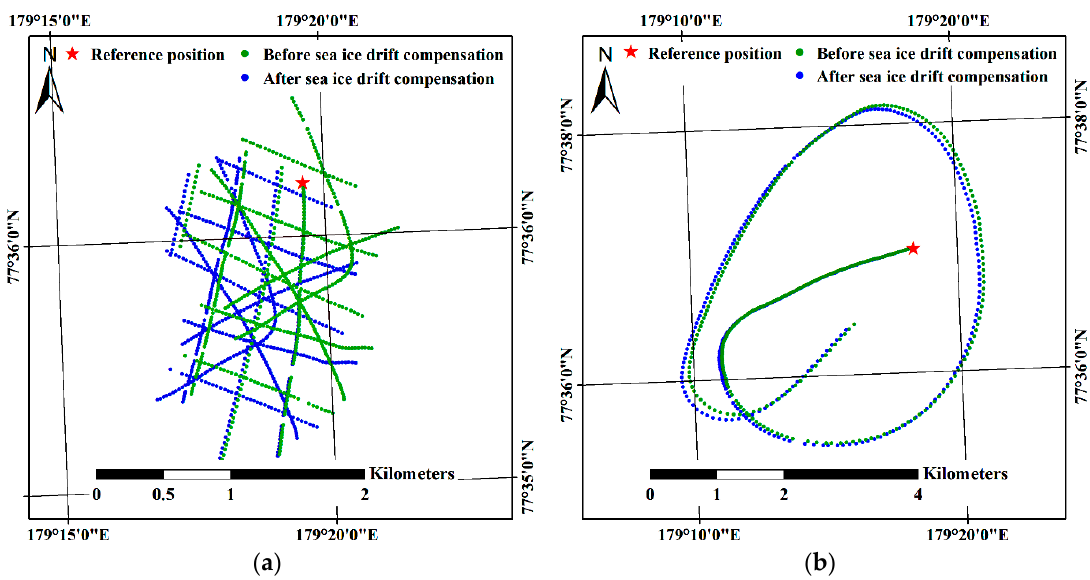
Figure 7. Compensation for the effect of sea ice drift in the helicopter-borne VHR images: ( a ) the imaging locations of Subset I before and after the compensation; and ( b ) the imaging locations of Subset II before and after the compensation.